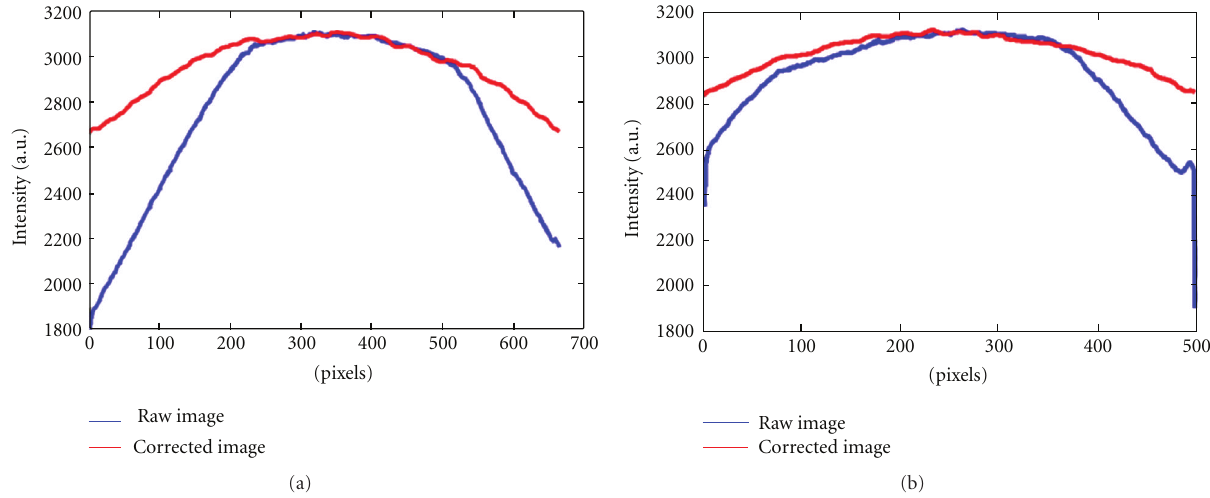
Figure 2: The cross-section profile of intensity from the raw and corrected image along (a) X axis and (b) Y